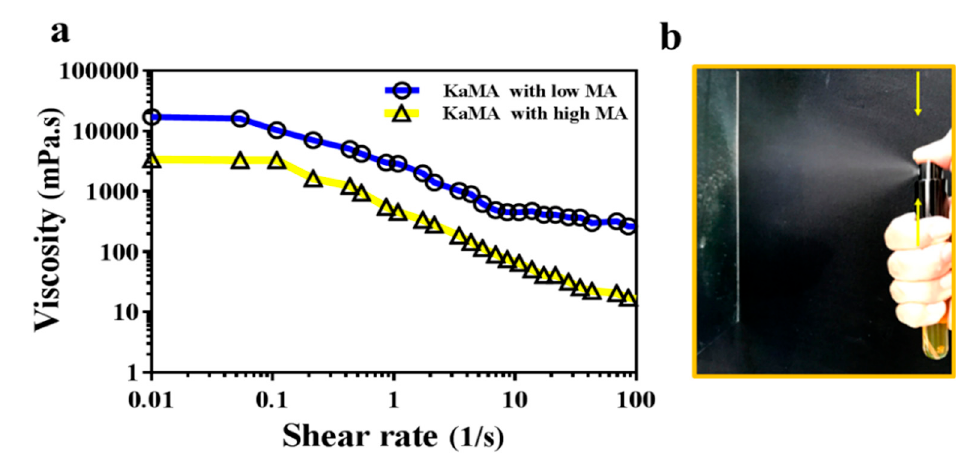
Figure 4. ( a ) Rheological evaluation of KaMA hydrogel with low and high MA degree; as shear rate increases, the viscosity drops; ( b ) spraying ability of the KaMA hydrogel with high MA [60] .